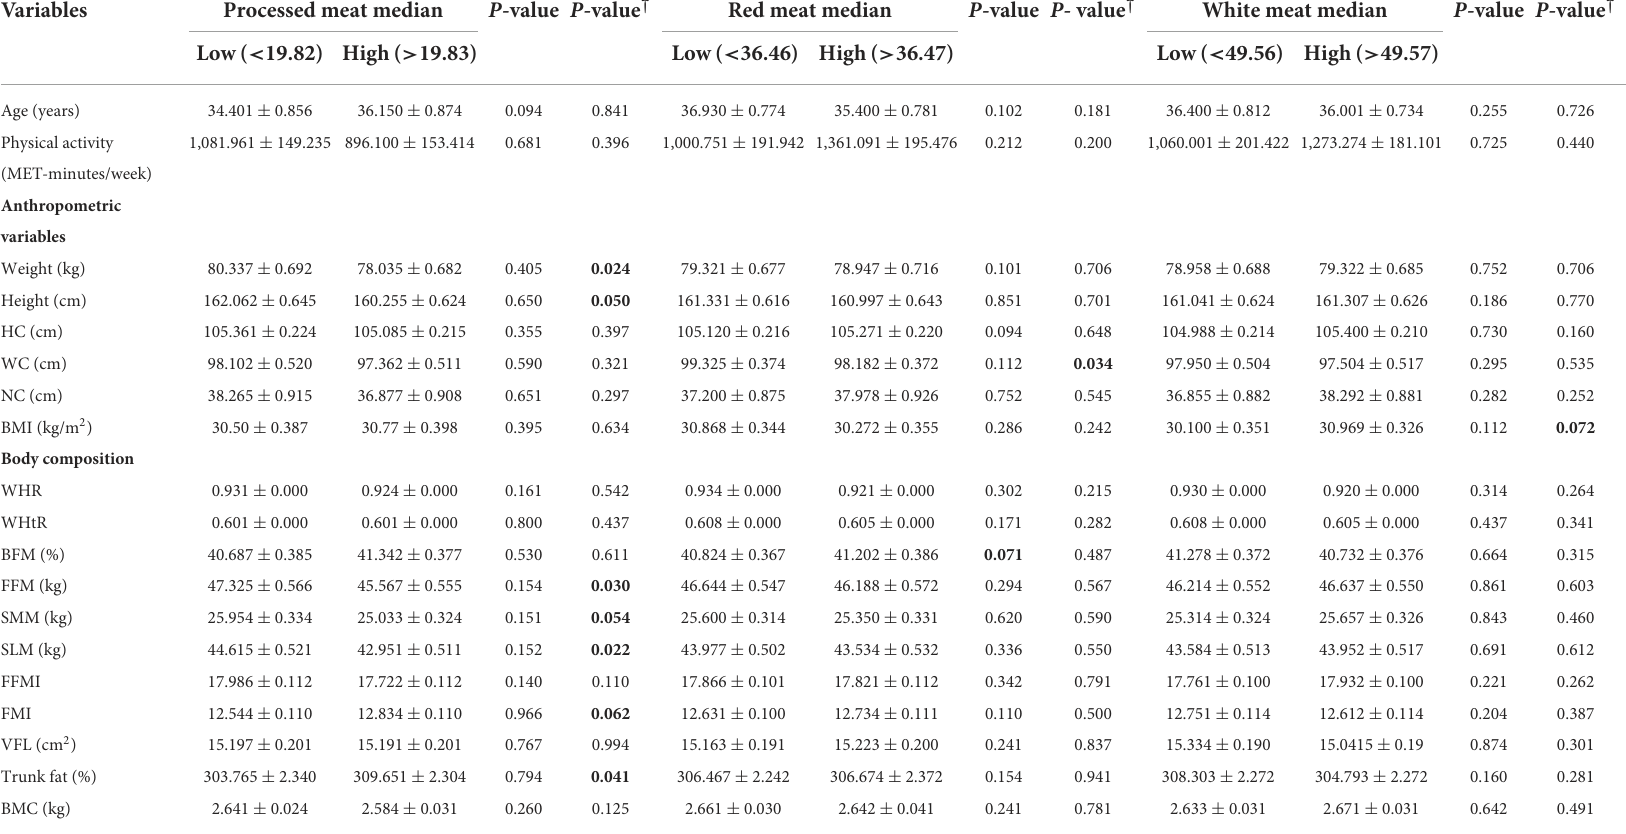
TABLE 1 Study participant characteristics between medians of processed meat, red meat, and white meat (g/d) in 391 obese and overweight women.